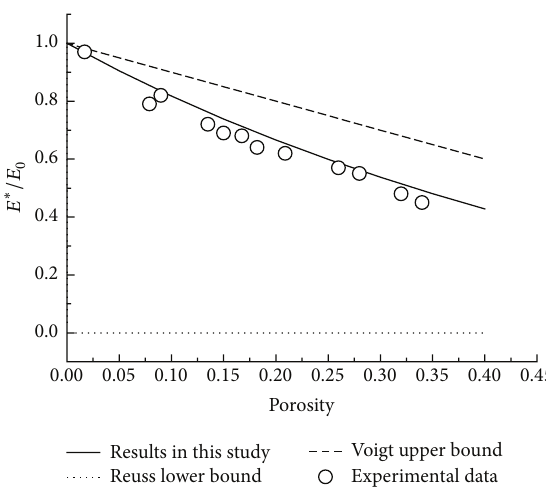
Figure 9: The comparison among the results obtained with the proposed micromechanical model, those obtained experimentally [49], those estimated by the Reuss lower bound, and the Voigt upper bound for the effective Young modulus of the porous matrix.